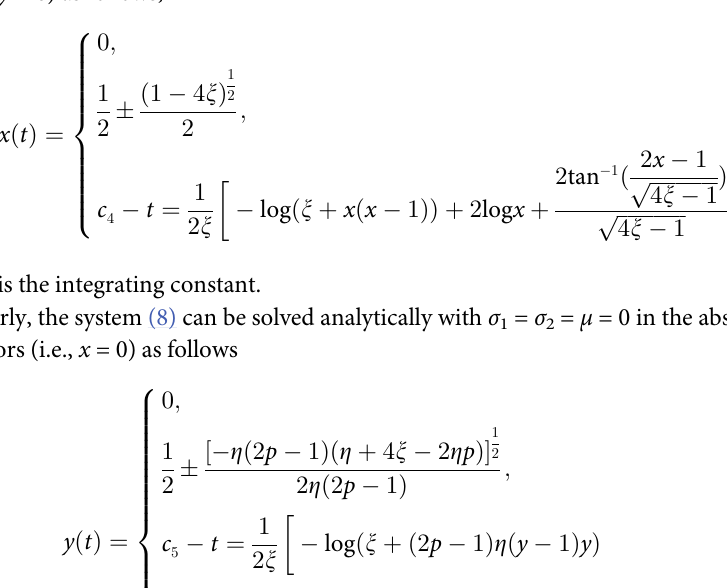
ffiffiffiffiffiffiffiffiffiffiffiffiffiffiffiffiffiffiffiffi p ð 2 p (cid:0) 1 Þ Z